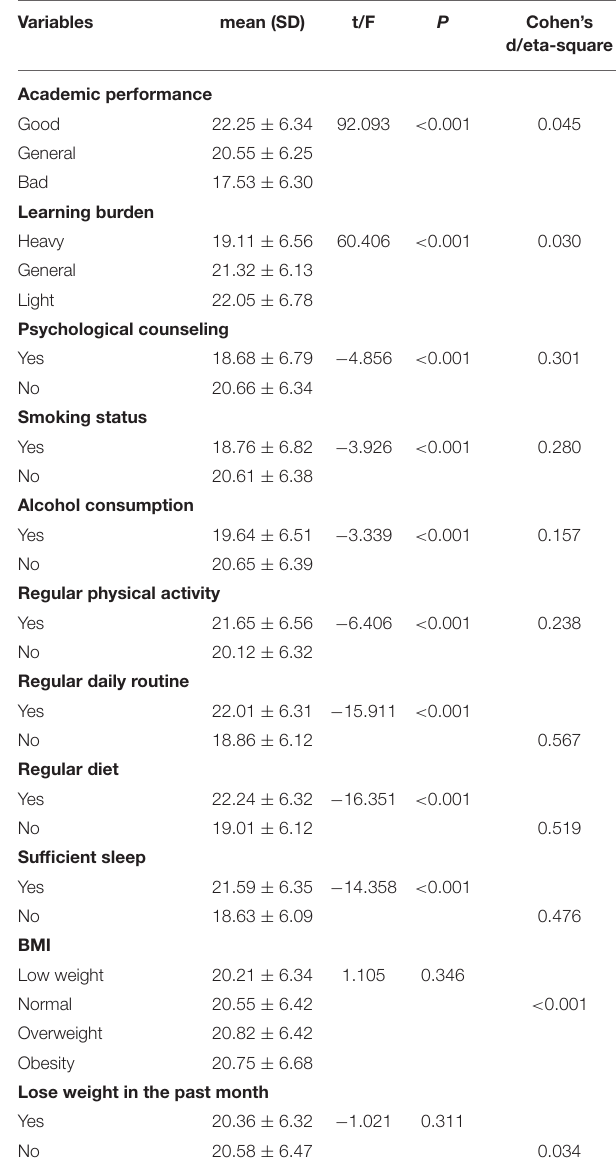
TABLE 2 | The satisfaction with life of college students in facing the epidemic of